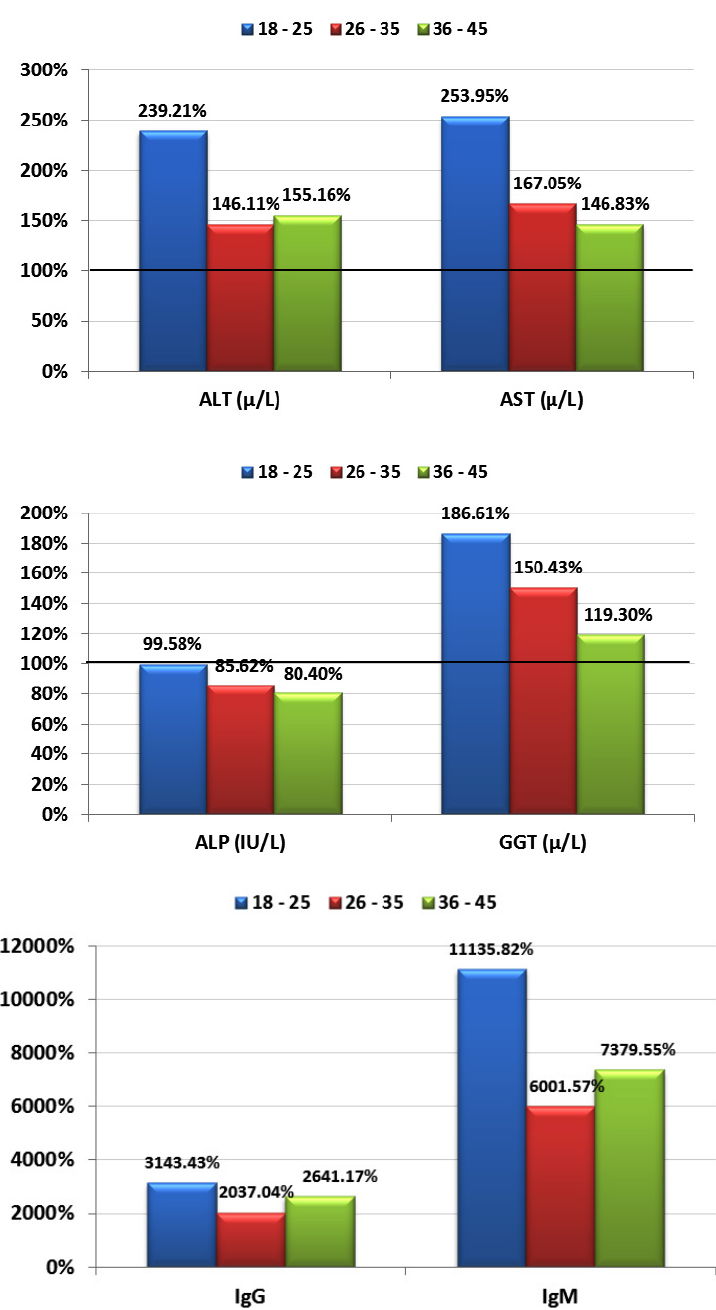
Fig. 1. (a,b,c) Percentage change of Igg and IgM all parameters in each age group